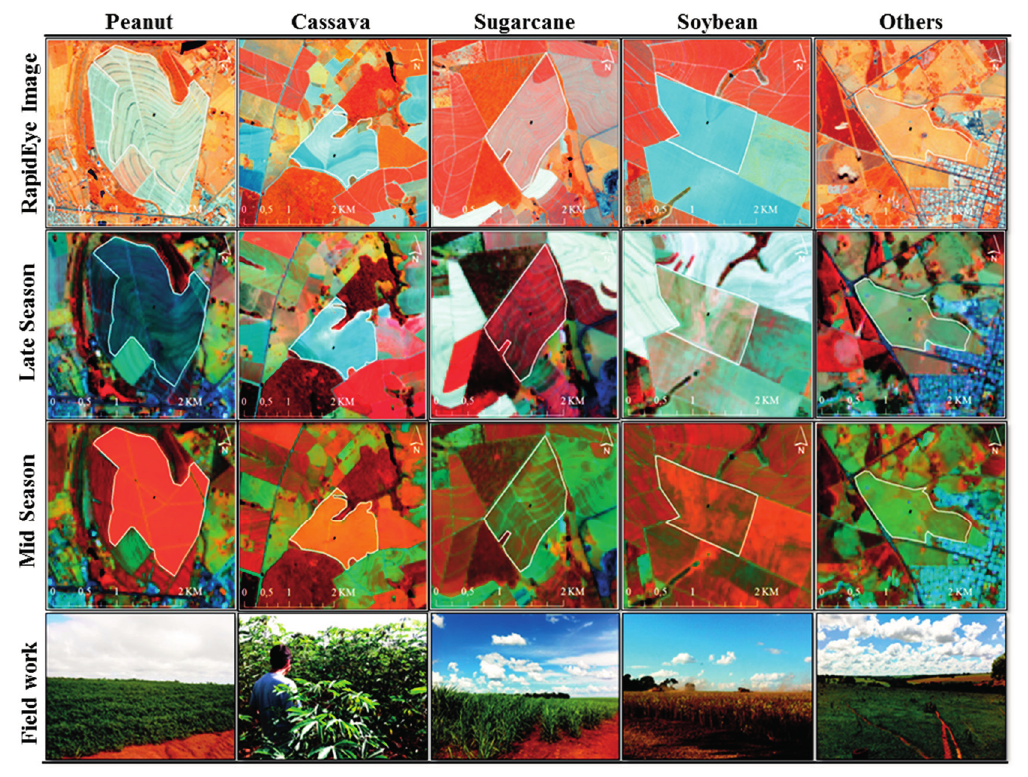
Figure 3. Example images for the classes peanut , cassava , sugarcane , soybean and others (field boundaries in white). Note that the class “others” includes not only agricultural areas but also constructions, water, etc. The photos from the field work were made around 40 days after the “Mid Season” images were taken (e.g., in March). The RapidEye image is shown in band combination 453 and was taken July 2011. The Landsat 8 images are shown in band combination 564 and were taken in August 2013 (Late Season) and January 2014 (Mid